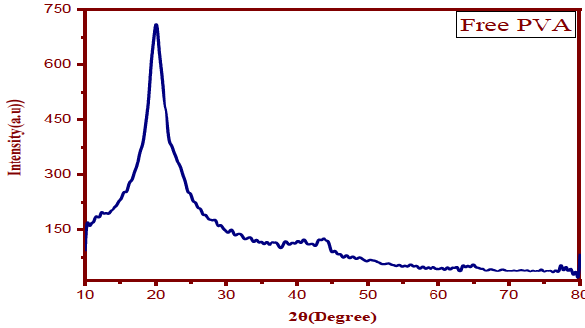
Figure 6: XRD pattern of pure PVA nano film.